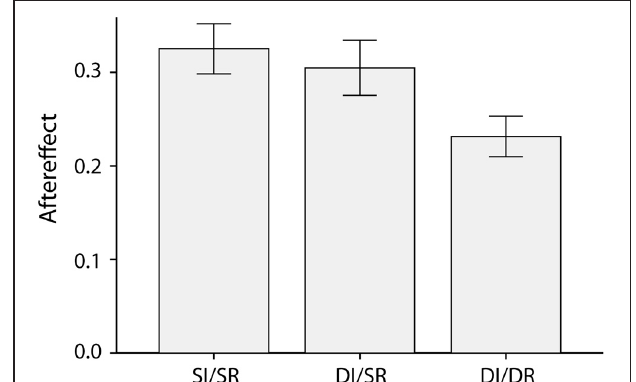
FIGURE 2 | Average emotion aftereffects, calculated as the difference between the proportion of ambiguous test-faces categorized as afraid following an angry adapting and a frightened adapting face, for the three different combinations of adapting and test face (Same Identity/Same Race, Different Identity/Same Race and Different Identity/Different Race).